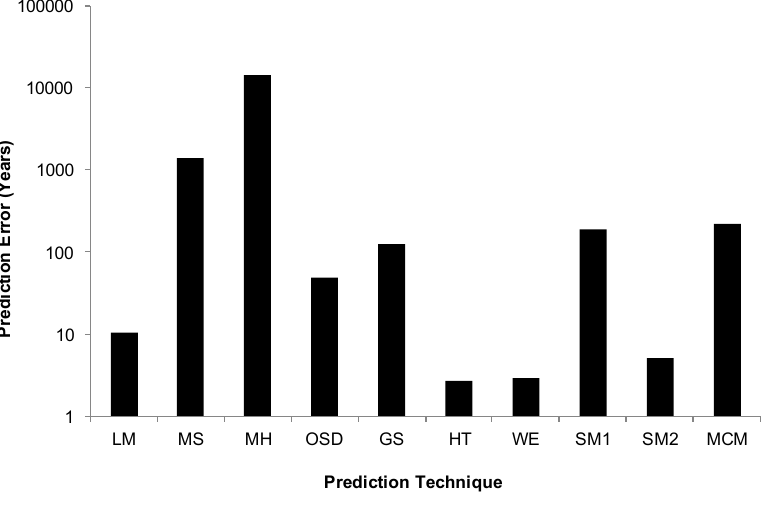
Figure 12. Error analysis of the conventional and modern predictive approaches.